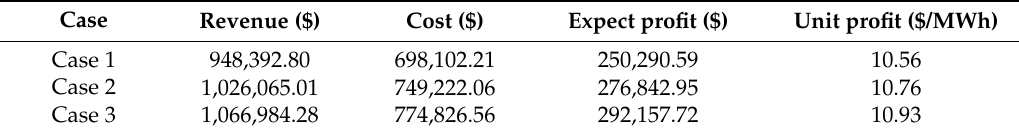
Figure 7. Purchased power from spot market. Table 7. Comparison of economic benefits.